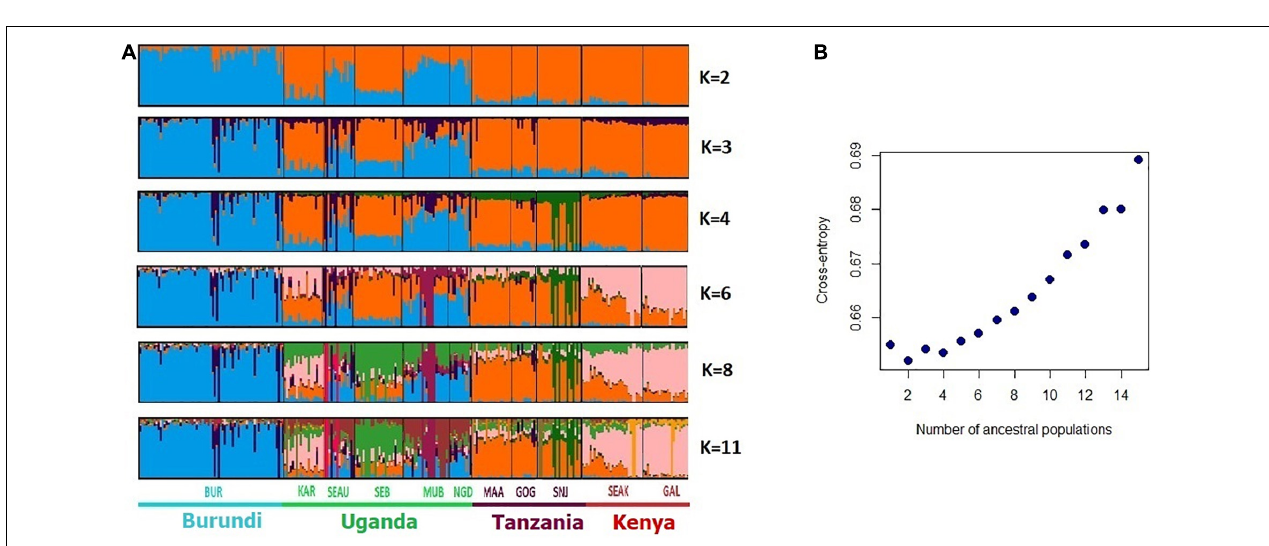
FIGURE 3 | Bayesian clustering performed with ADMIXTURE software on the West/Central African goats. (A) Display for different values of K , with K = number of clusters; (B) cross-entropy plot for the number of cluster K = 1–15.